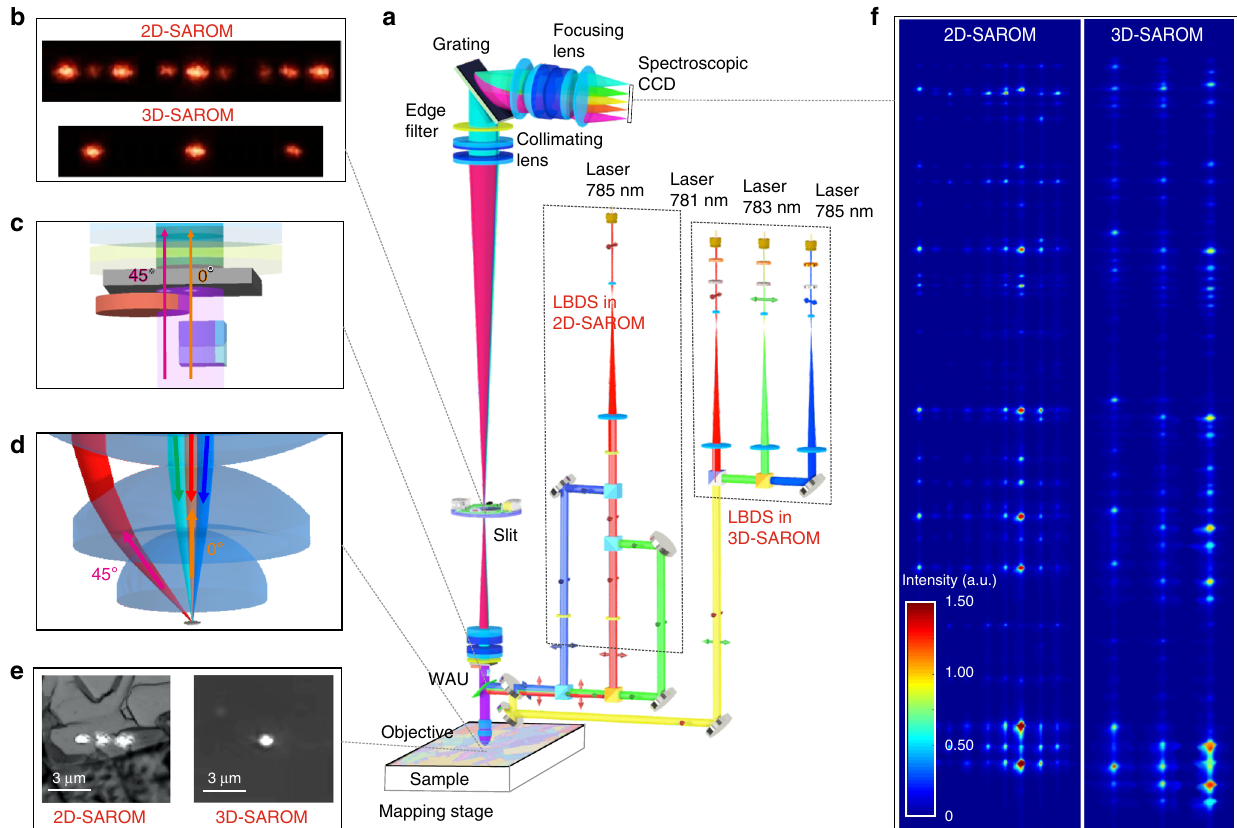
Fig. 2 SAROM system design. a Optical setup of SAROM in 2D and 3D mapping con fi gurations designed in Zemax Optics Studio 17, b images of polarized beams on the spectroscopic slit focal plan, c on-axis and off-axis Raman scattering beam path through Wollaston Analyzer Unit (WAU), d sample illumination by laser beams and Raman signal collection geometry in on-axis (0°) and off-axis (45°) scattering pathways, e microscopy images of the laser spots on the sample in 2D- and 3D-SAROM con fi gurations, f images of resulting Raman signals from carbamazepine drug obtained on a spectroscopic CCD in the 2D and 3D-SAROM con fi